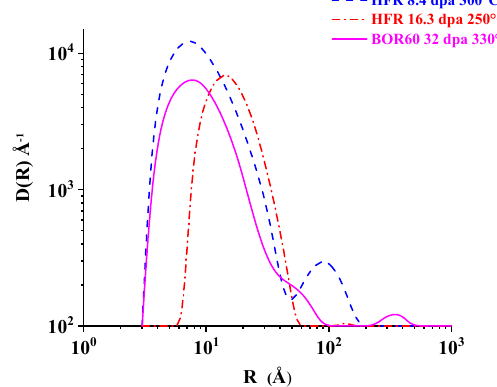
Figure 10. Best-fit micro-voids volume distributions of Figure 9 for Eurofer97 neutron irradiated to 8.4 dpa 300 °C (dashed line) and 16.3 dpa 250 °C (dash-dotted line) compared with best-fit distribution of Eurofer97 neutron irradiated at BOR60 reactor to 32 dpa at 330 °C (corresponding SANS measurements shown in Reference [13]).